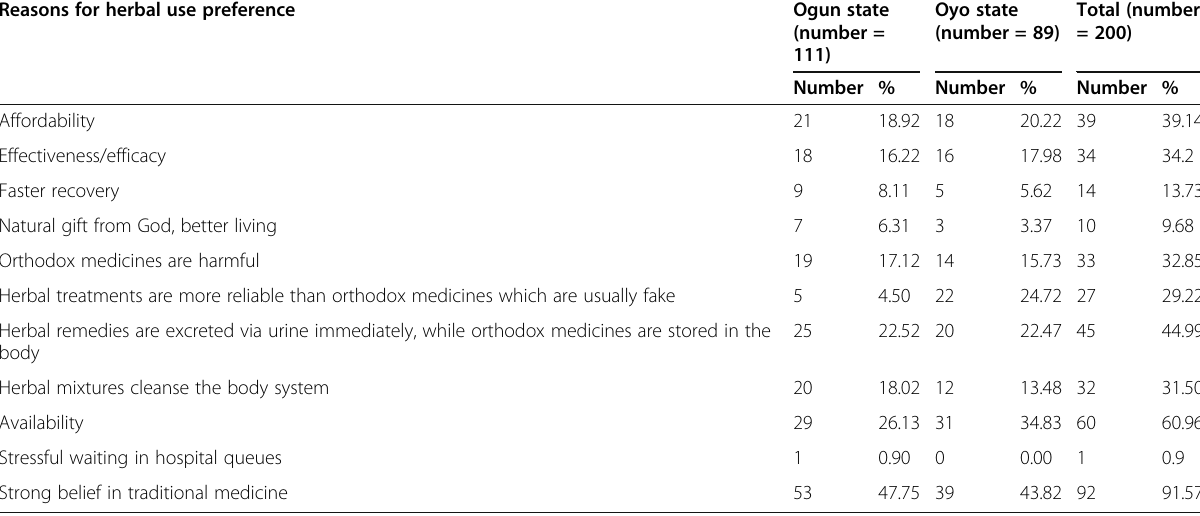
Table 2 Reasons for herbal use preference among respondents Reasons for herbal use